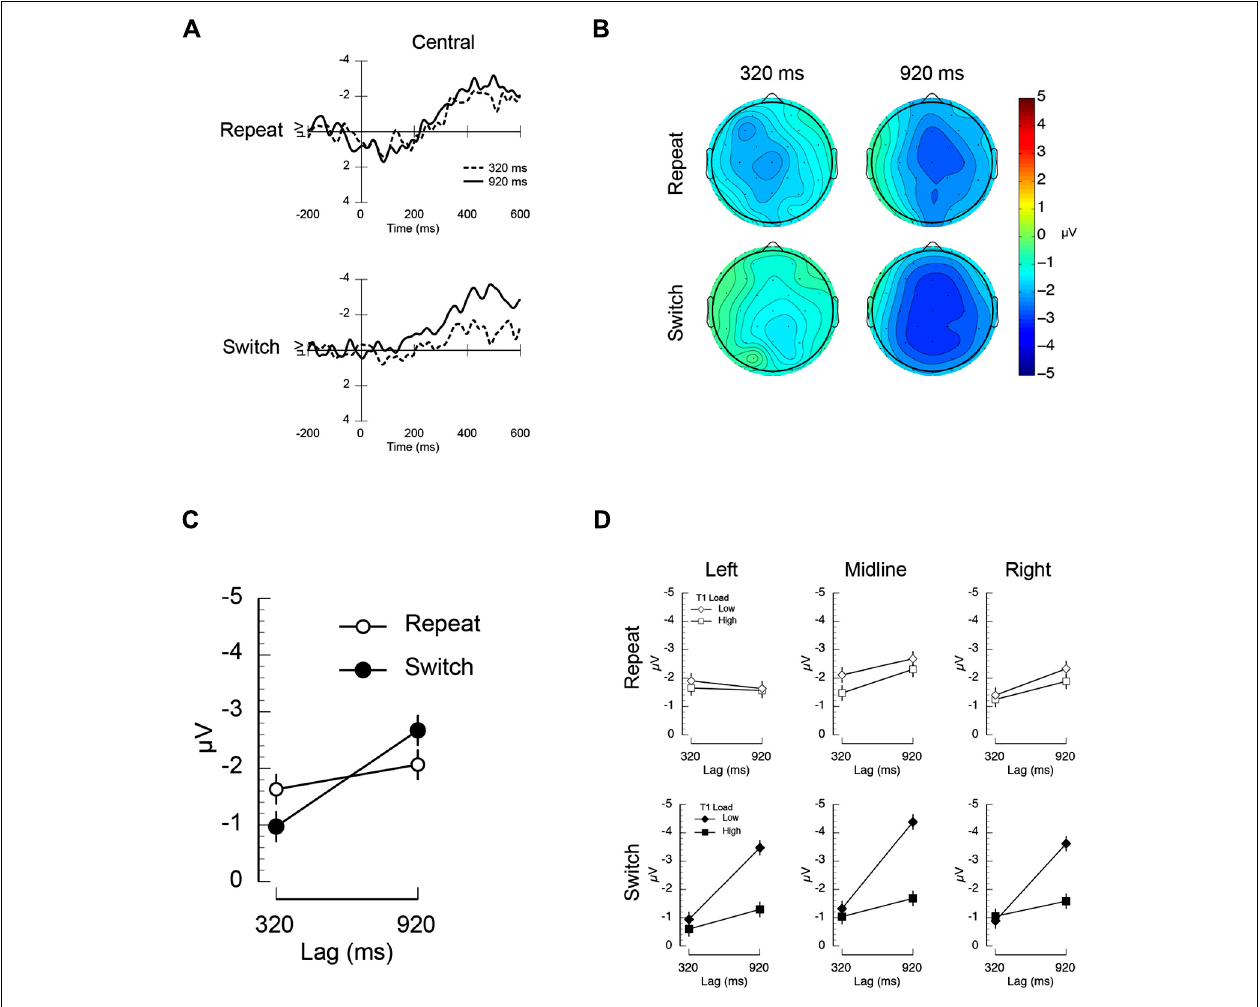
computed over the 300–500 ms post-T2 time window and averaged across all electrode sites included in the analysis (see Materials and Methods). (D) Mean N400 amplitude measured at left (F3/C3/P3), midline (Fz/Cz/Pz), and right electrodes (F4/C4/P4) plotted as a function of inter-trial dependency (repeat/switch), lag (320/920 ms), and T1 load